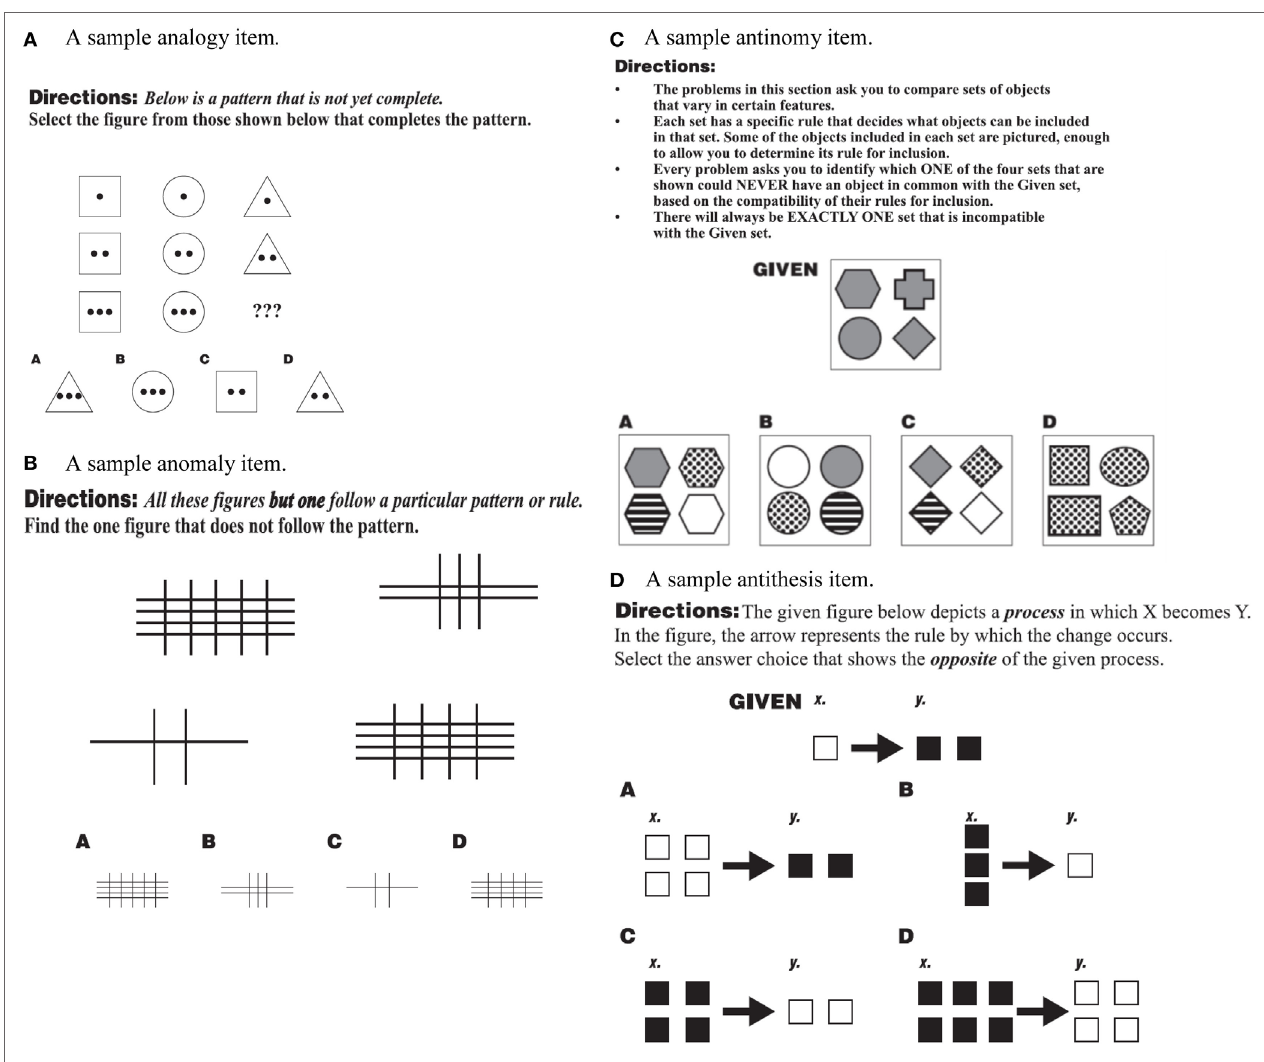
FiGurE 2 | (a–d) Sample items from the test of relational reasoning (TORR) for the analogy, anomaly, antinomy, and antithesis scales. (a) A sample analogy item . (B) A sample anomaly item. (c) A sample antinomy item. (d) A sample antithesis